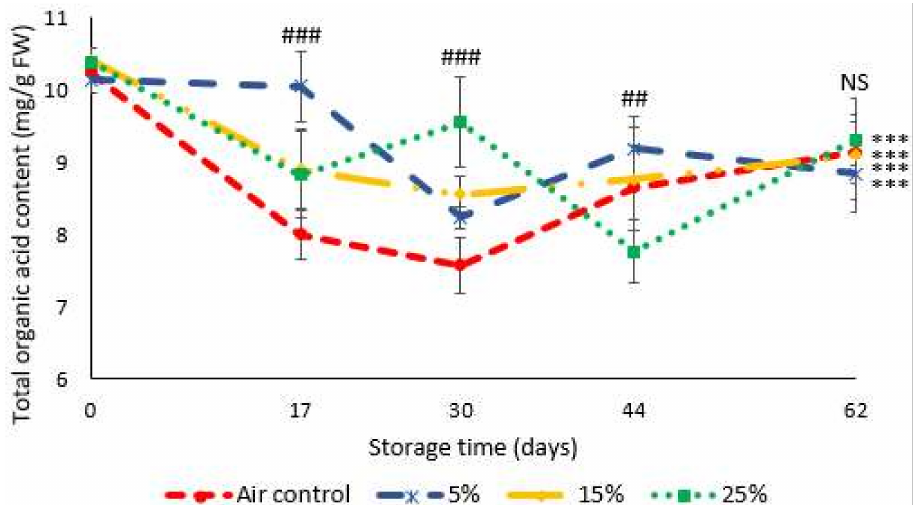
Figure 3. Blueberry ‘Liberty’ fruit total organic acid content under the air control and controlled atmospheres (5% CO 2 , 5% O 2 , 90% N 2 (5%); 15% CO 2 , 5% O 2 , 80% N 2 (15%); and 25% CO 2 , 5% O 2 , 70% N 2 (25%)) for different storage times (mg/g FW). ***, p < 0.001 (versus storage = 0, within each storage condition). ##, p < 0.01; ###, p < 0.001 (versus air storage, for each storage